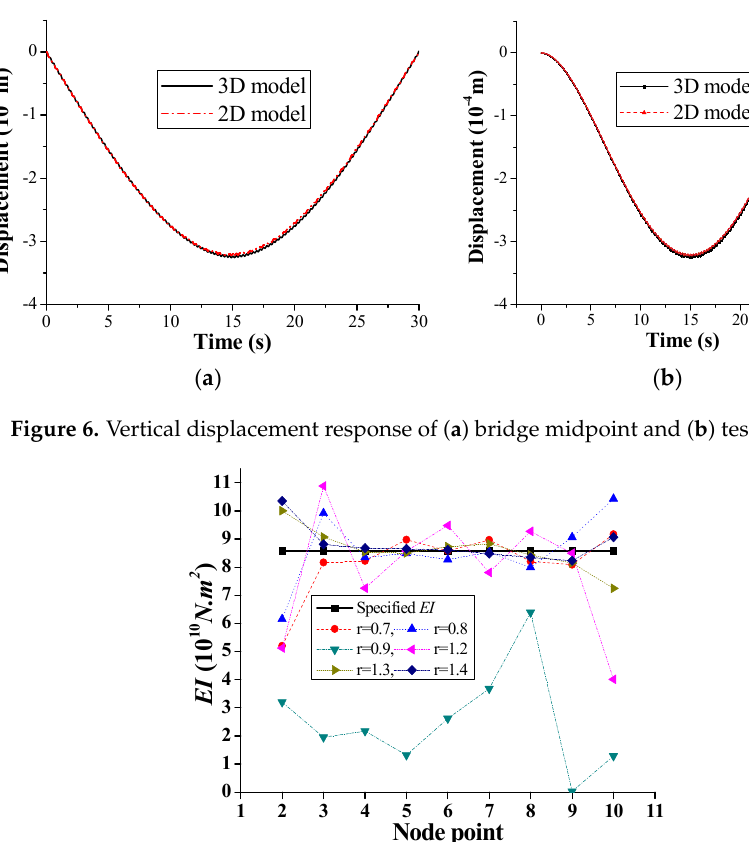
Figure 7. Simulation results of the calculated EI for elements along the bridge for different r values.